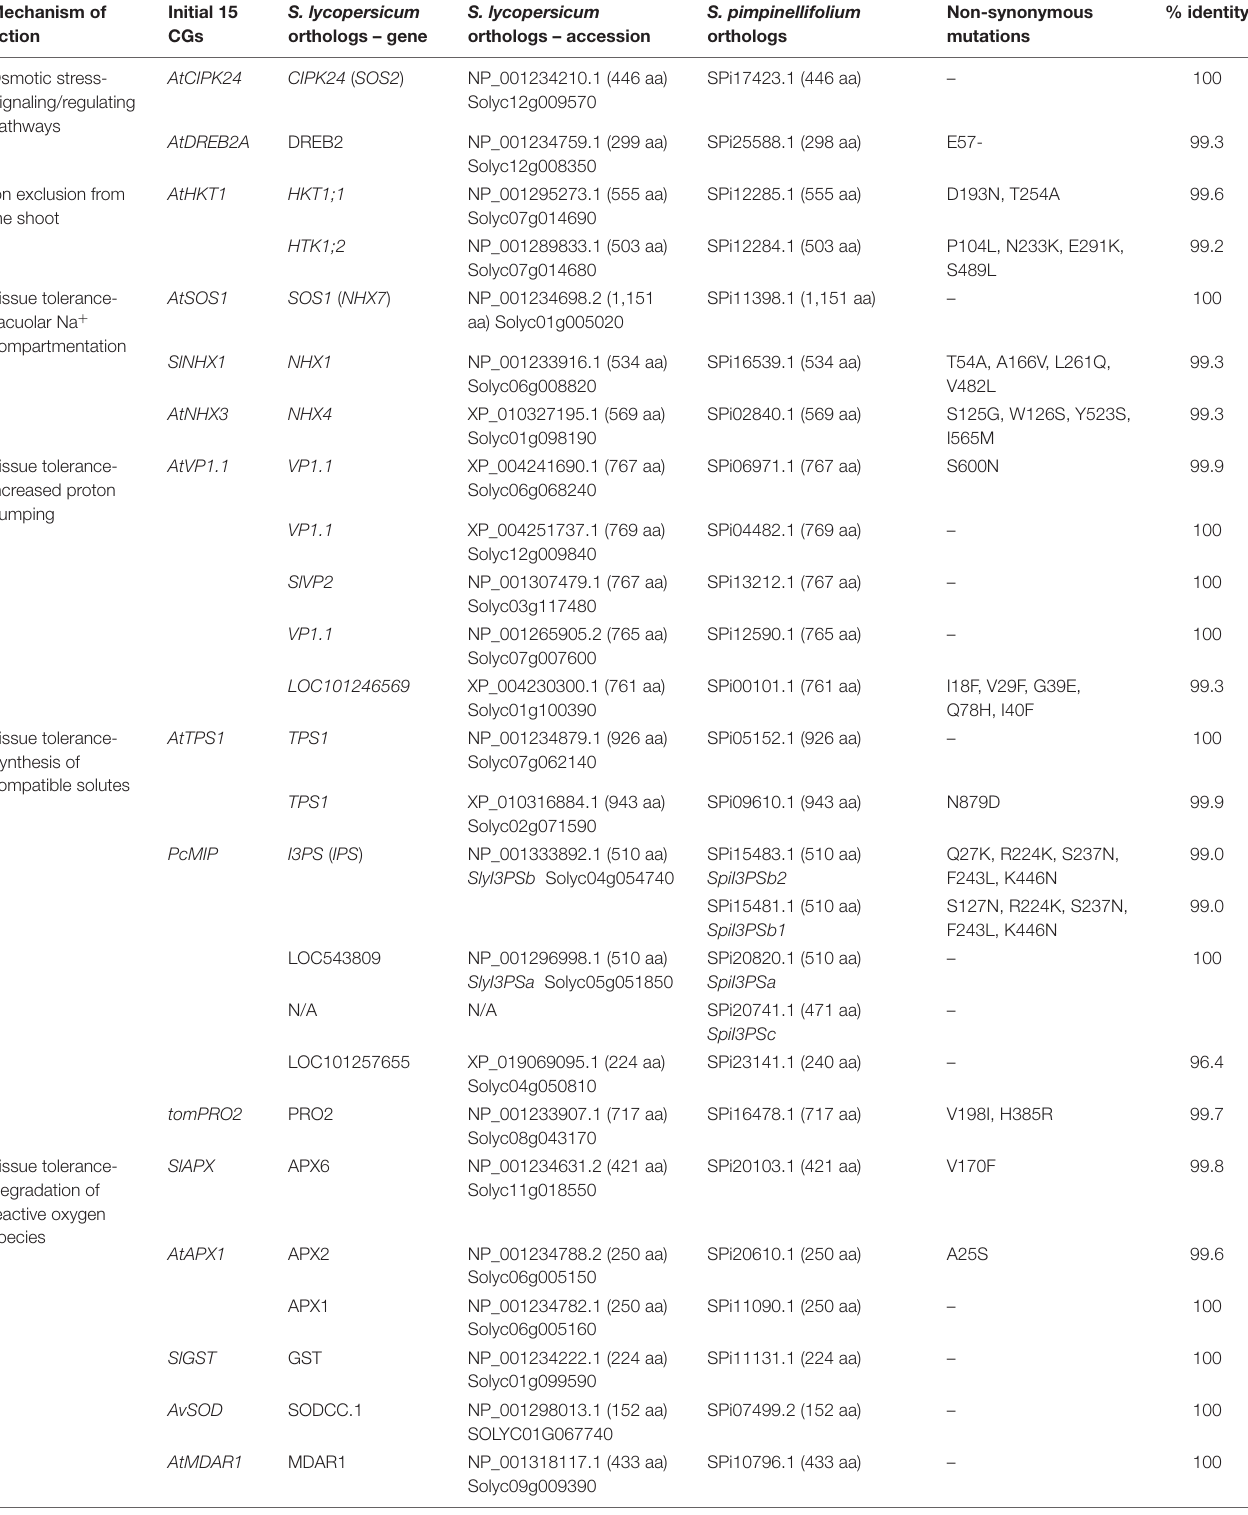
TABLE 3 | List of candidate genes for salinity tolerance in S. pimpinellifolium and S. lycopersicum . Mechanism of